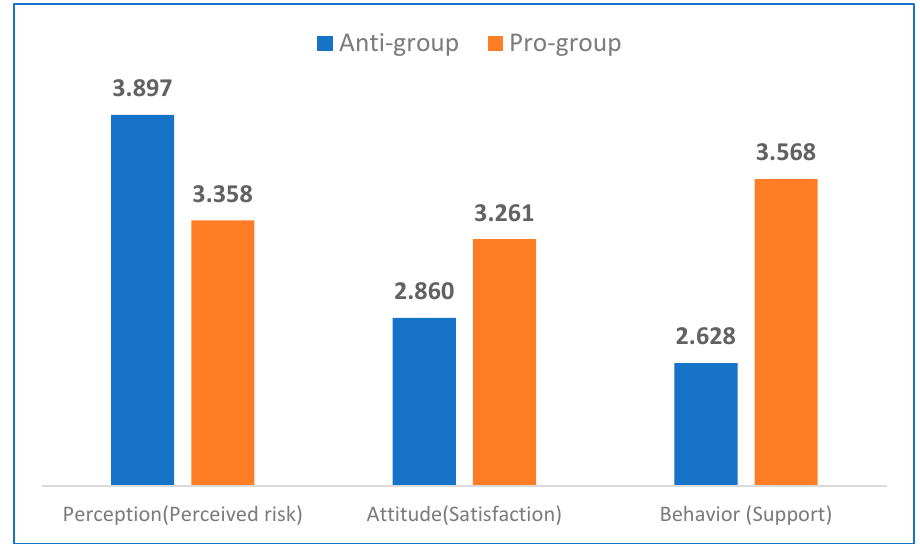
Figure 2. Means of perceived risk, satisfaction, and support in the pro-group and the anti-group.